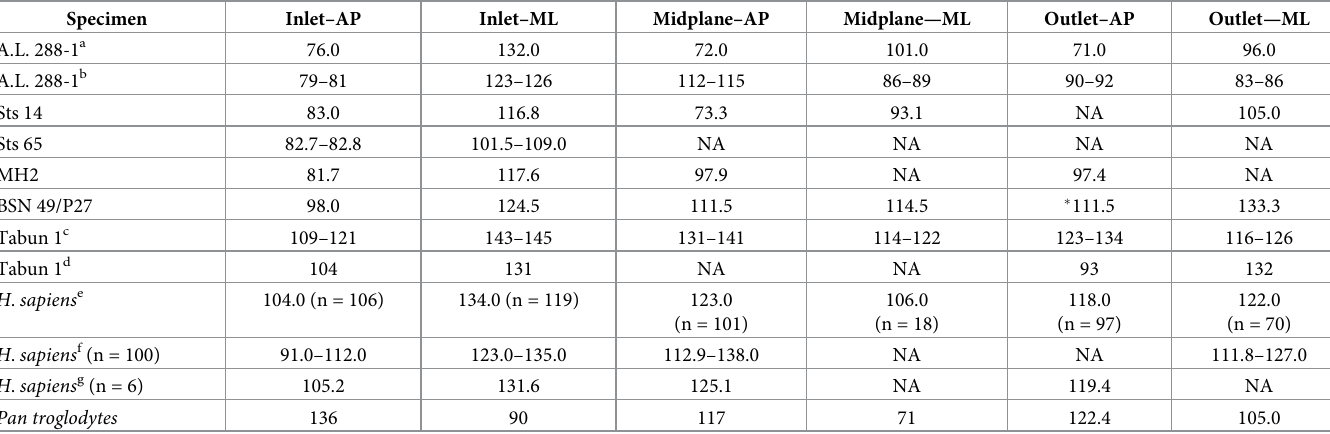
Table 1. Female pelvic dimensions for fossil hominins, modern humans, and